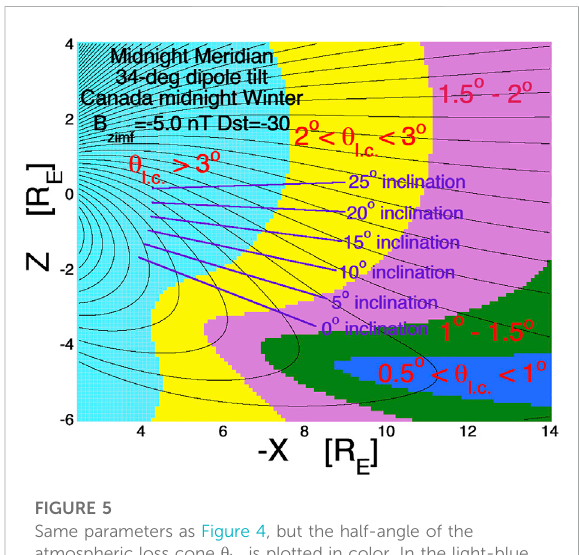
FIGURE 5 Same parameters as Figure 4, but the half-angle of the atmospheric loss cone θ λ c is plotted in color. In the light-blue shaded region θ l.c. > 3 ° , in the yellow region 2 ° < θ l.c < 3 ° , in the pink shaded region 1.5 ° < θ l.c < 2 ° , in the green shaded region 1 ° < < 1.5 ° , and in the blue shaded region 0.5 ° < θ θ l.c